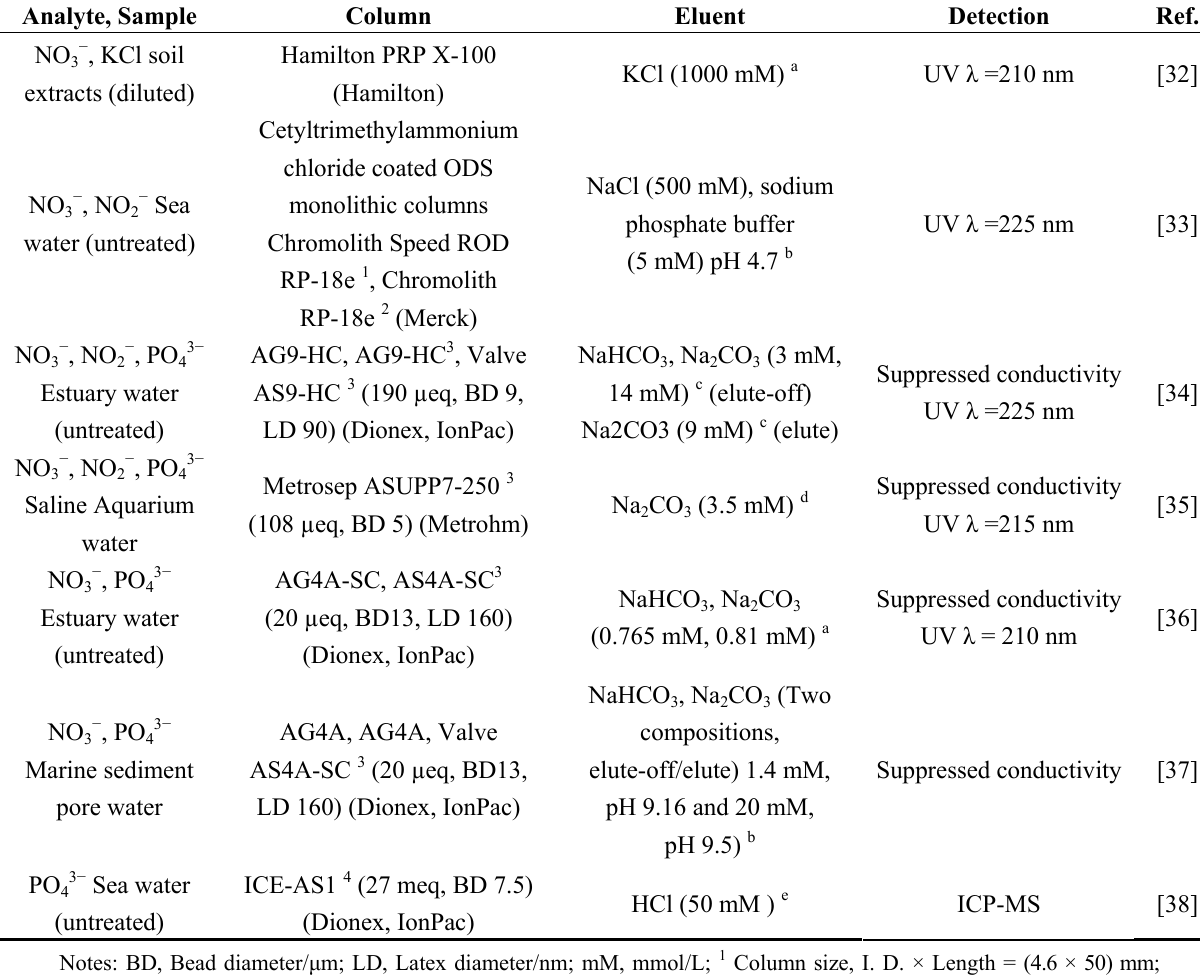
Table 3. Ion chromatographic determinations of concentrations of nutrients in samples with high ionic strength.